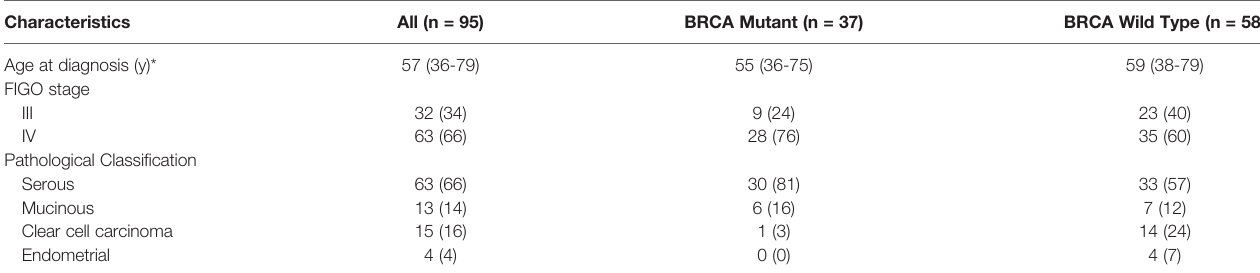
TABLE 1 | Patients and Clinical Characteristics.